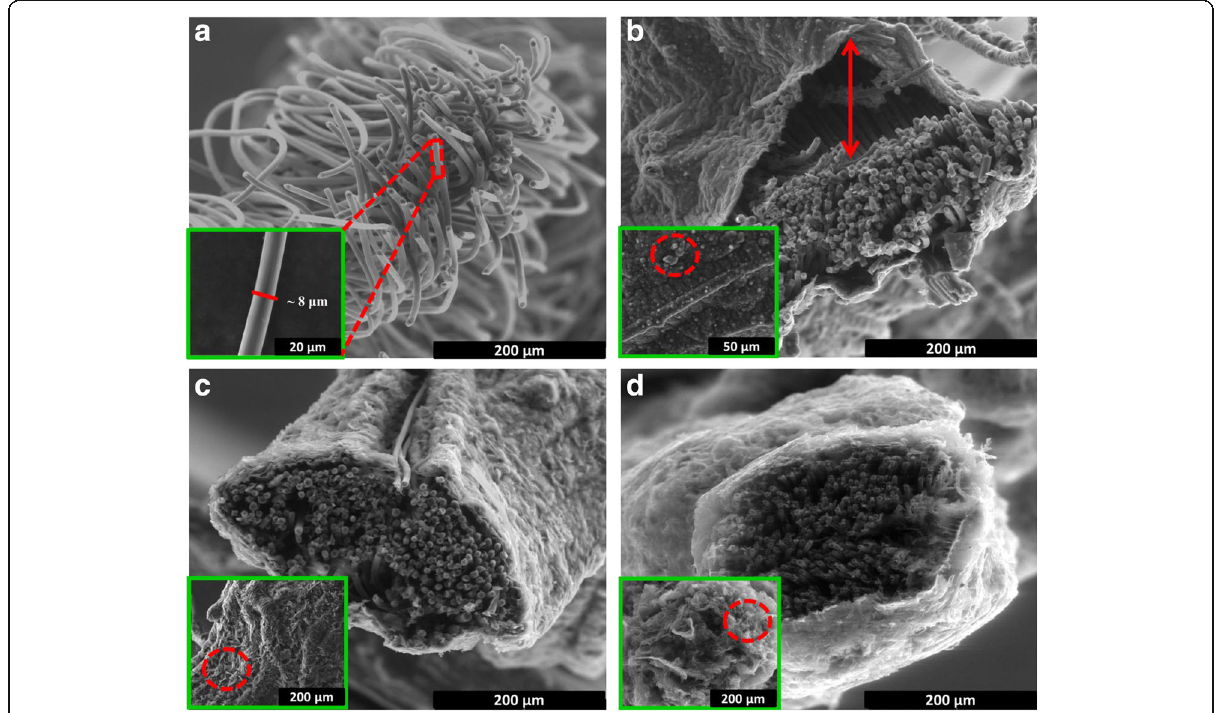
Fig. 1 Cross-sectional FESEM images along with images of surface morphologies ( inset ) of as-prepared electrodes. a Bare CBF. b CBF/PPy. c CBF/ PPy-rGO. d